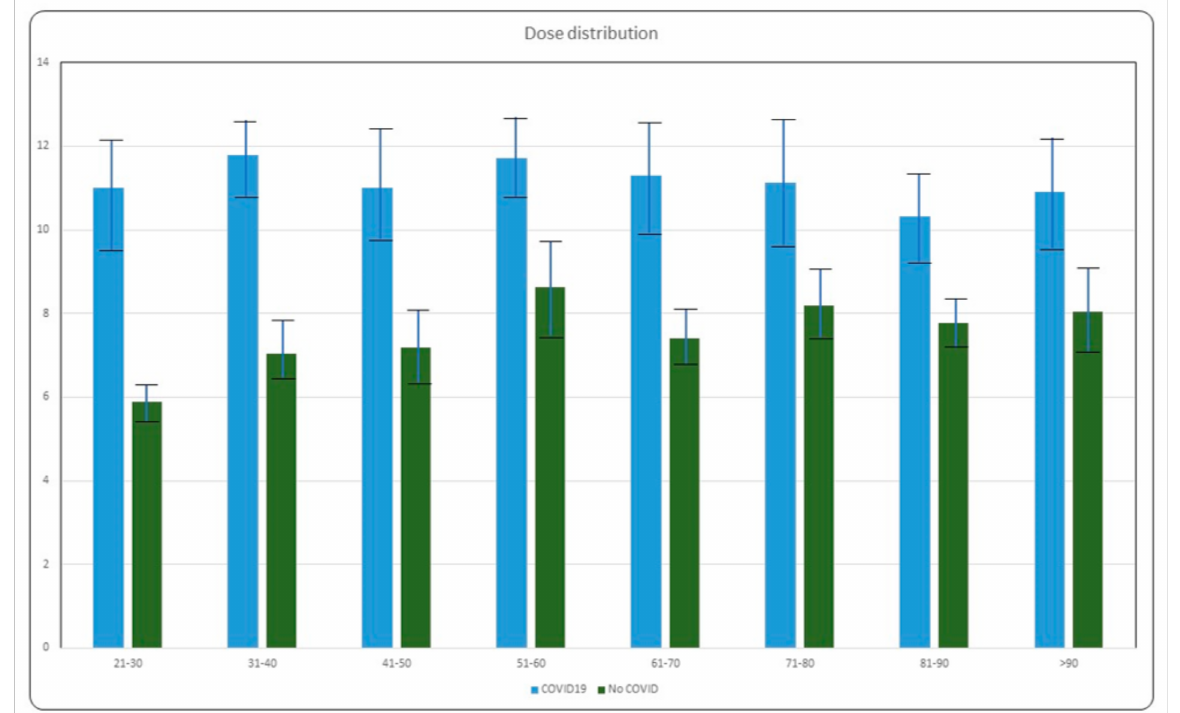
Figure 1. Comparison of dose distribution in COVID-19 and no COVID patients by age group.